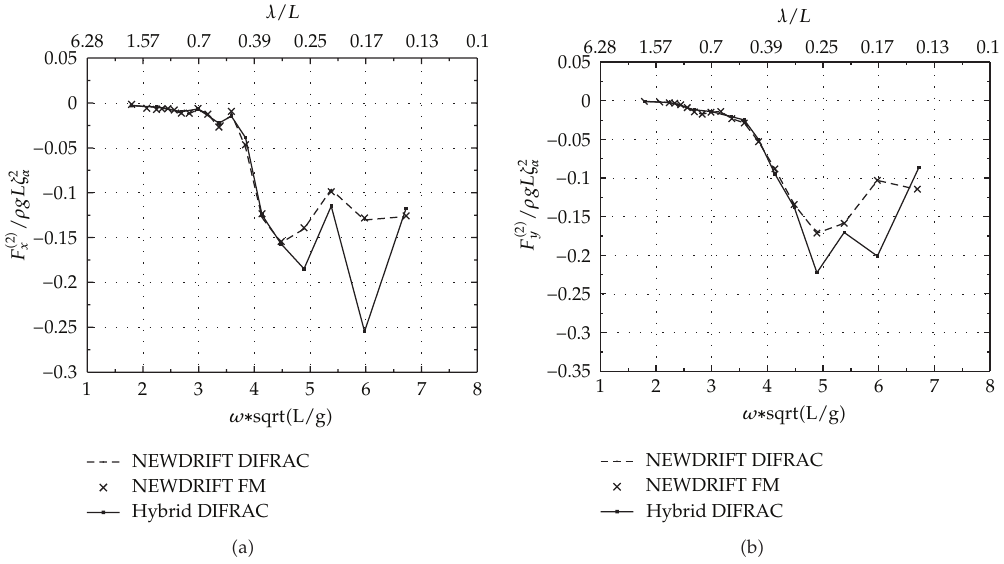
Figure 8: Di ff raction drift force in longitudinal and transverse directions; χ (cid:7) 135 ◦